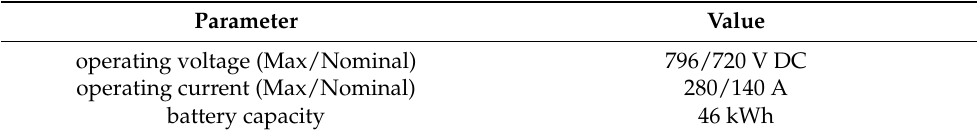
Table 3. Battery pack main characteristics.